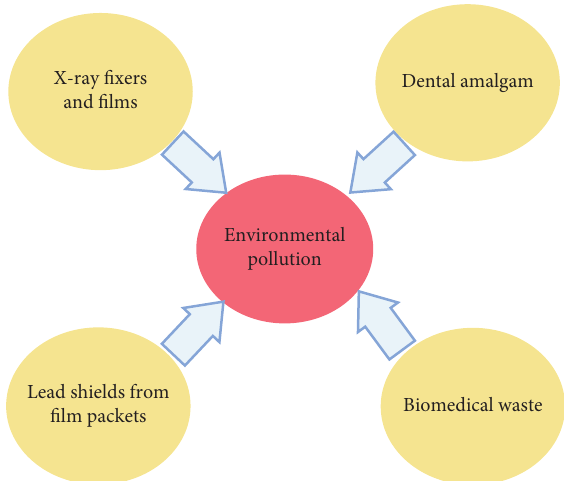
Figure 1: Key sources of pollution caused by heavy metals in dentistry. Created using